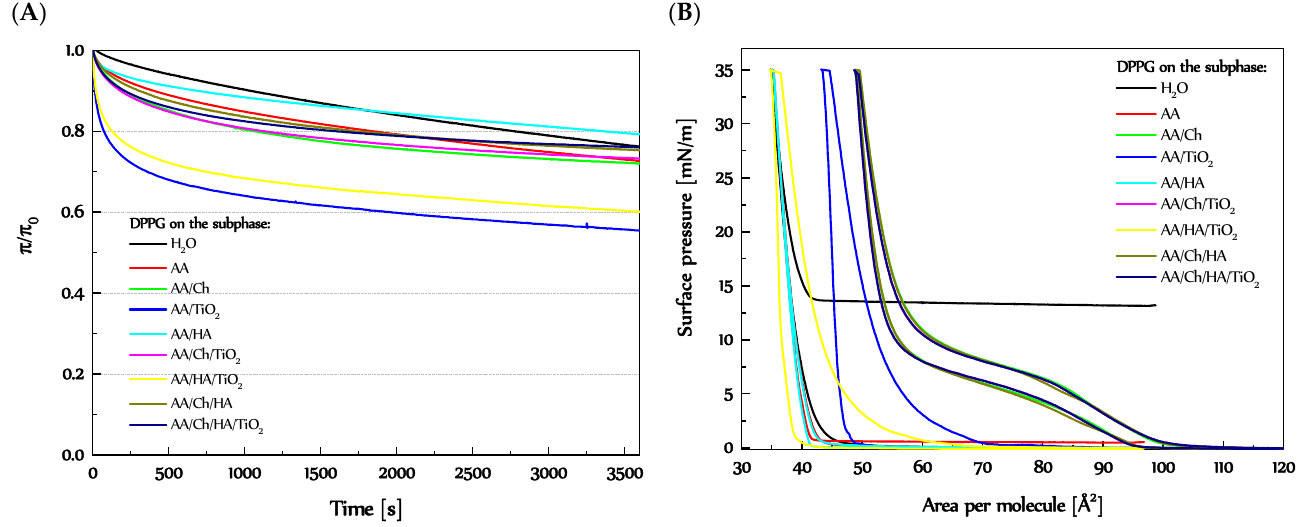
Figure 2. ( A ) π / π 0 = f(t) (more details Figure S1) and ( B ) hysteresis loops obtained by compression and decompression of the DPPG monolayers on the individual subphases.